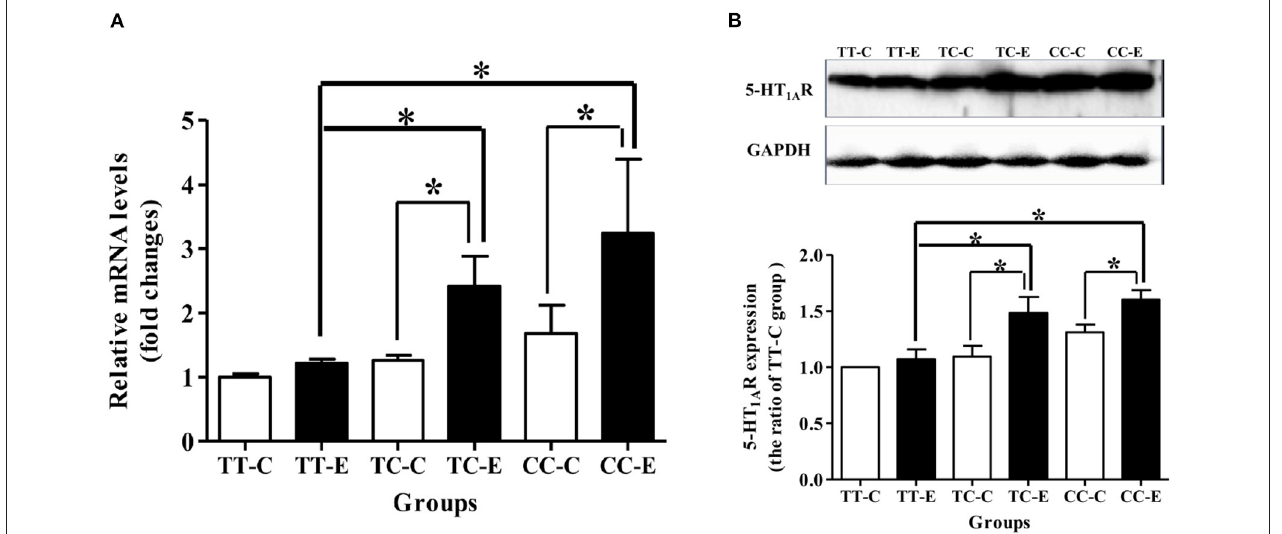
FIGURE 5 | 5-HT 1A receptor mRNA and protein levels in the rat hippocampus after 30 mW/cm 2 microwave exposure. (A) mRNA level; (B) protein levels. * P < 0.05. The histogram panels show semiquantified protein level data. Each value is expressed as the ratio of the level in the indicated group to the level in the control TT genotype (TT-C) group. * P <